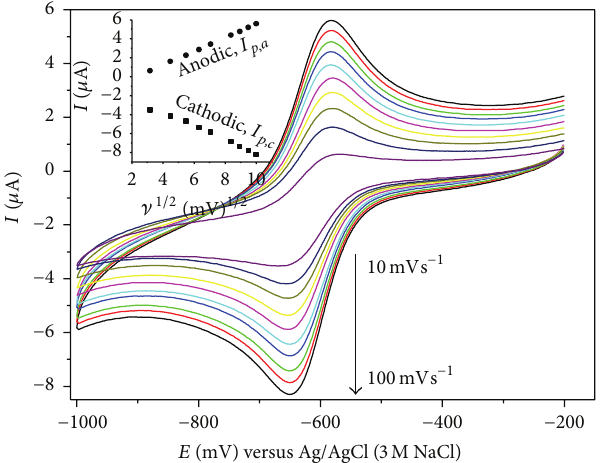
Figure 5: Cyclic voltammograms of biosensor (CYP3A4 | GNPs | OvOxPpy || GCE) in argon-saturated PBS (50mM, 100mM KCl) containing 1mM CoSep 3+